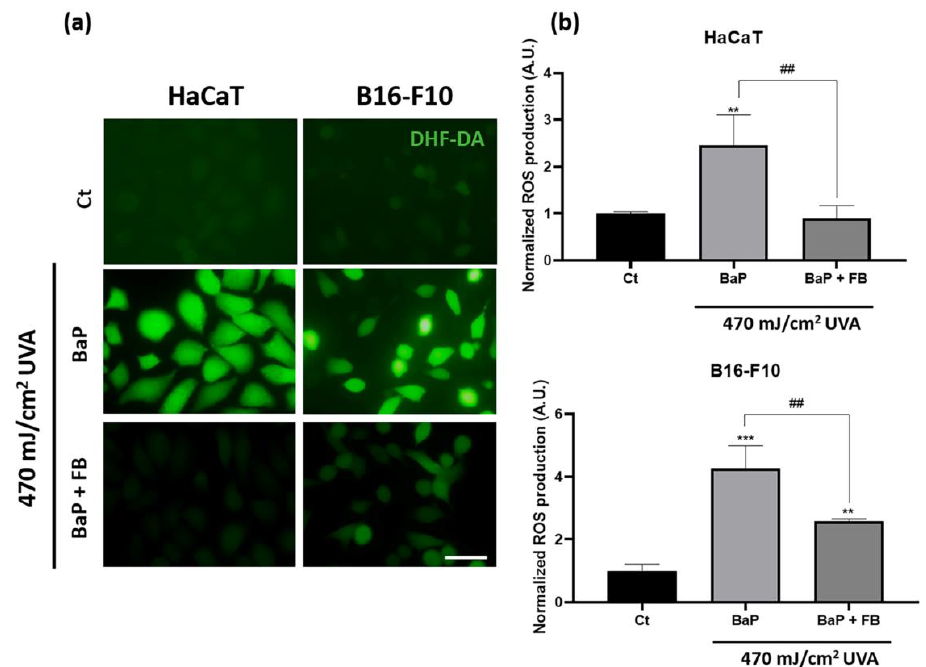
Figure 3. Reactive oxygen species generation in HaCaT and B16-F10 cells with BaP and FB treatment followed by UVA light exposure. ( a ) Cells were incubated with BaP and BaP + FB, followed by DHF-DA incubation. Subsequently, cells were irradiated with 470 mJ/cm 2 of UVA light and observed under the fluorescence microscope using blue light excitation. Green fluorescence revealed ROS production. Cells treated with BaP and UVA showed the highest fluorescence intensity, while cells treated with both BaP and FB prior to UVA irradiation diminished ROS levels. Scale bar: 40 µm. ( b ) ROS production was quantified using the ImageJ software. Cells treated with BaP and UVA light showed a significant increase in ROS generation when compared to control cells. Oxidative stress in cells treated with BaP and FB decreased significantly when compared to BaP + UVA in both cell lines. Error bars denote ± S.E.M. ( n = 3, one-way ANOVA **: p < 0.01; ***: p < 0.001; and n = 3, t -test ##: p < 0.01).